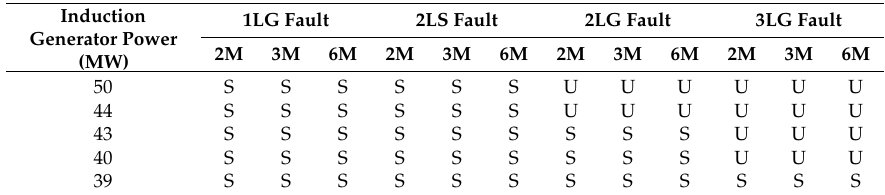
Table 1. Results of the transient stability of two-mass, three-mass and six-mass models (ignoring all types of damping) [52]. S, steady; U, unsteady.